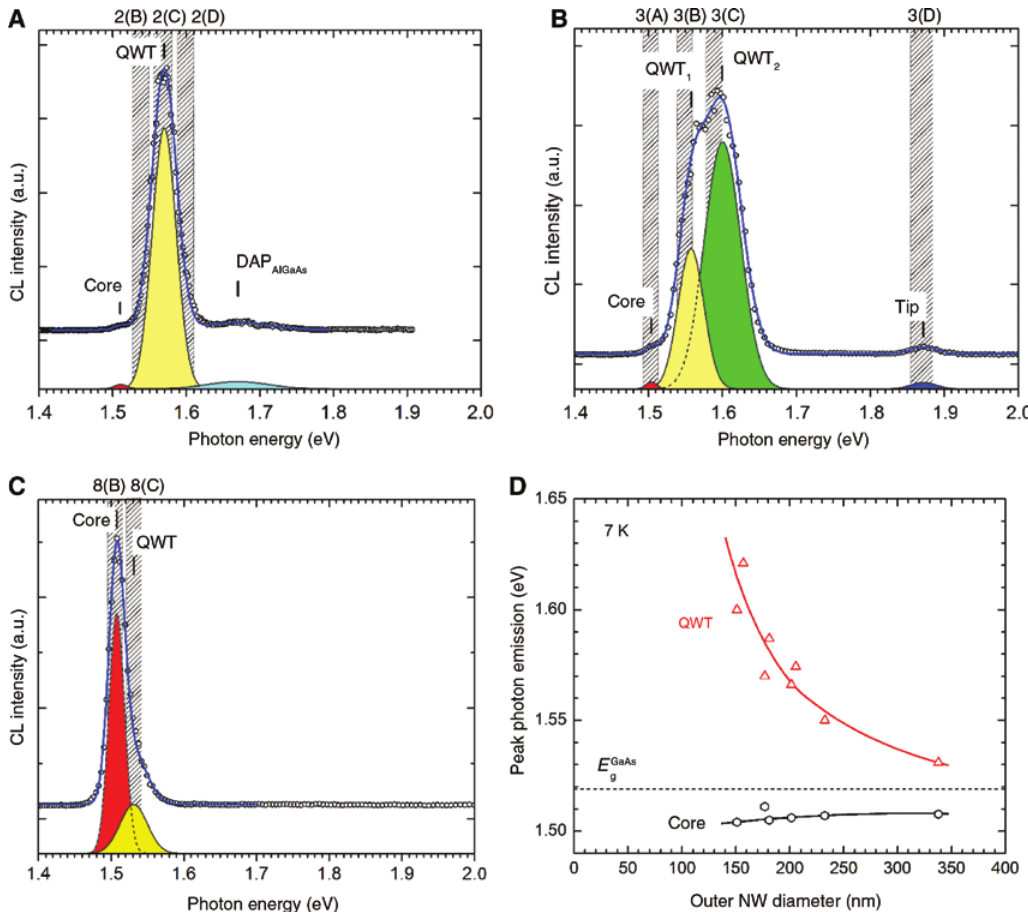
Figure 1: (A–C) Experimental CL spectra (○) recorded at 7 K for three different GaAs-AlGaAs core-multishell nanowires from Sample A (see Figures 2, 3, and 8 for corresponding FE-SEM and CL